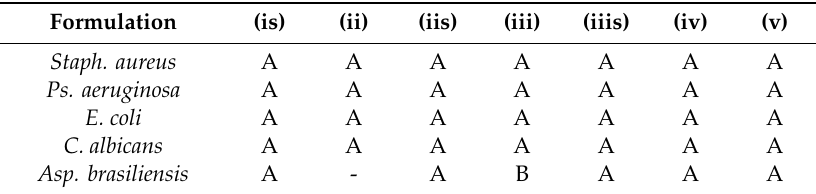
Table 5. Acceptance criteria according to the test for e ffi cacy of antimicrobial preservation Ph. Eur. 5.1.3. achieved by the formulations: (is) NHC conventionally preserved with 0.1% sorbic acid, (ii) 5% 2-methyl-2,4-pentanediol, (iis) 5% 2-methyl-2,4-pentanediol + 0.05% sorbic acid, (iii) 5%